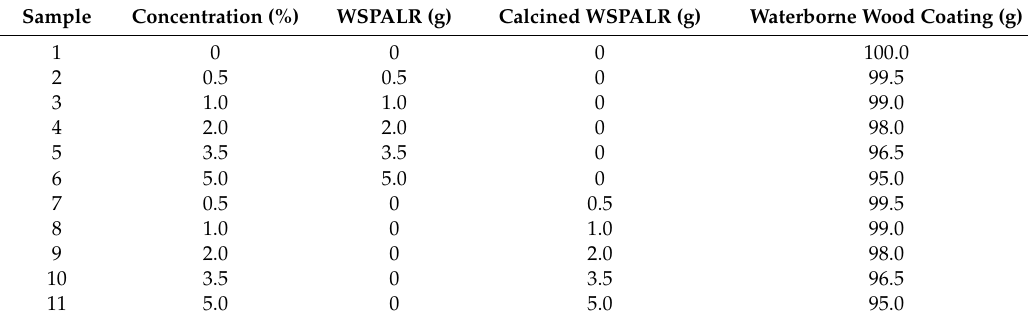
Table 1. Composition of waterborne